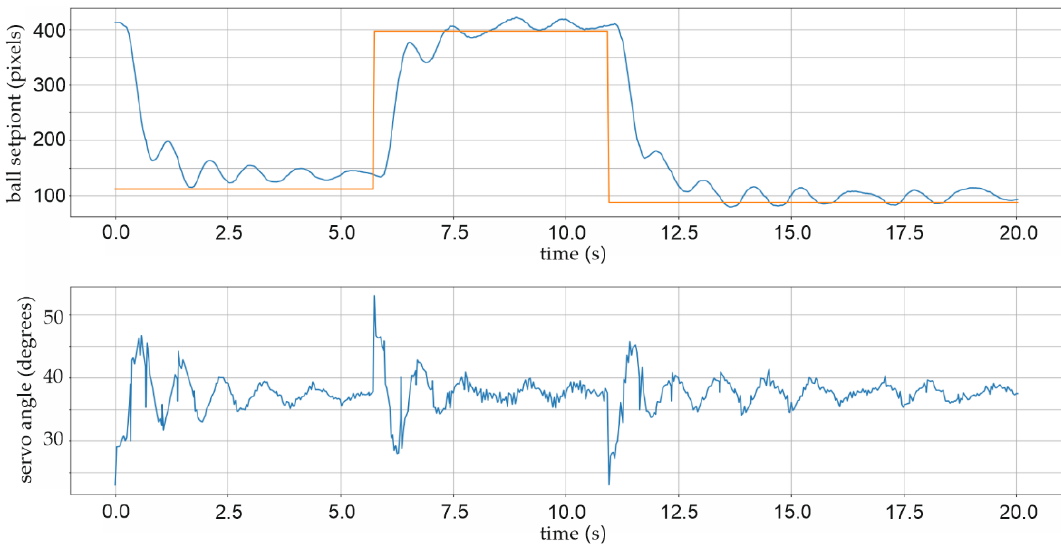
Figure 17. Experiment with the rough BPS plate surface.